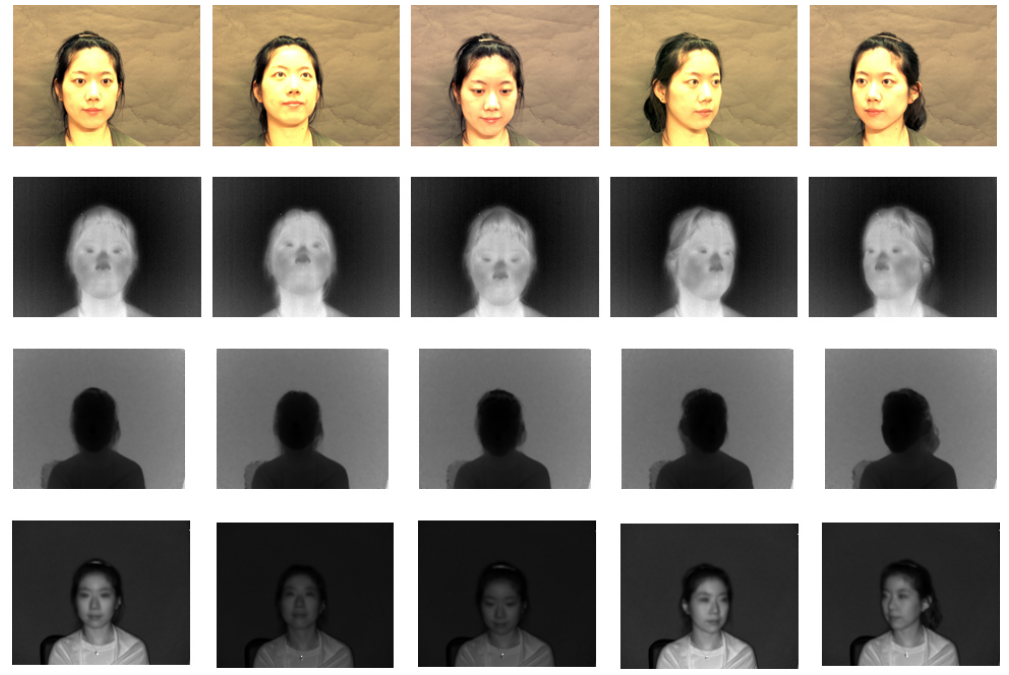
Figure 16. Example images from the database of five different facial poses: front, up, down, right and